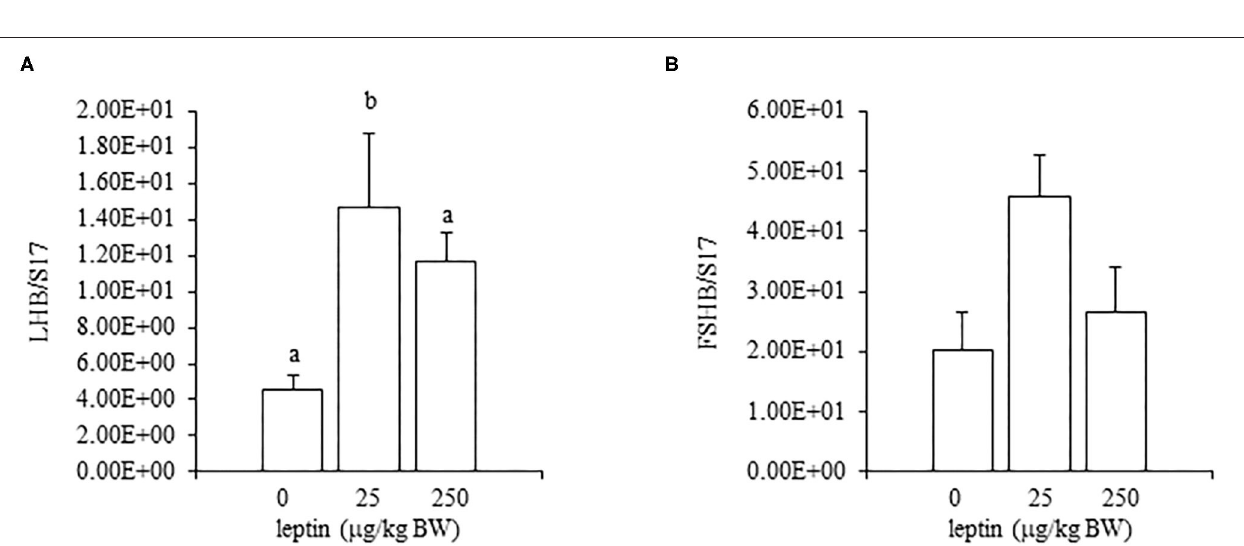
FIGURE 4 | The mRNA expression of LHB (A) and FSHB (B) at 24h after leptin treatment in the pituitary gland in the 7-day-old chicks. Chicks were injected i.p. with 0, 25, and 250 µ g/kg BW of rmleptin. The data represent the mean ± SEM ( n = 4–6), and bars with different superscripts are significantly